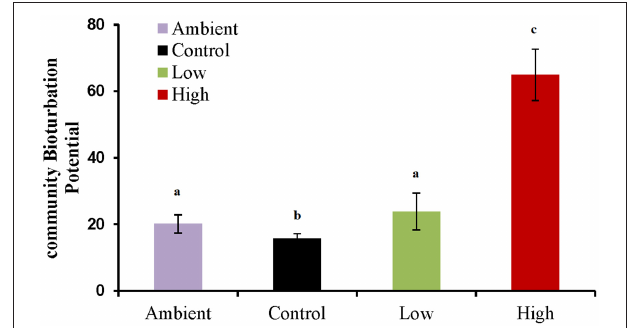
FIGURE 3 | Community Bioturbation Potential (BP c ) index values for each group of samples (Ambient, Control, Low eutrophication, High eutrophication). Statistically significant differences between groups ( p < 0.05) are indicated by letters “a, b, c.” Data are mean ± SD of three